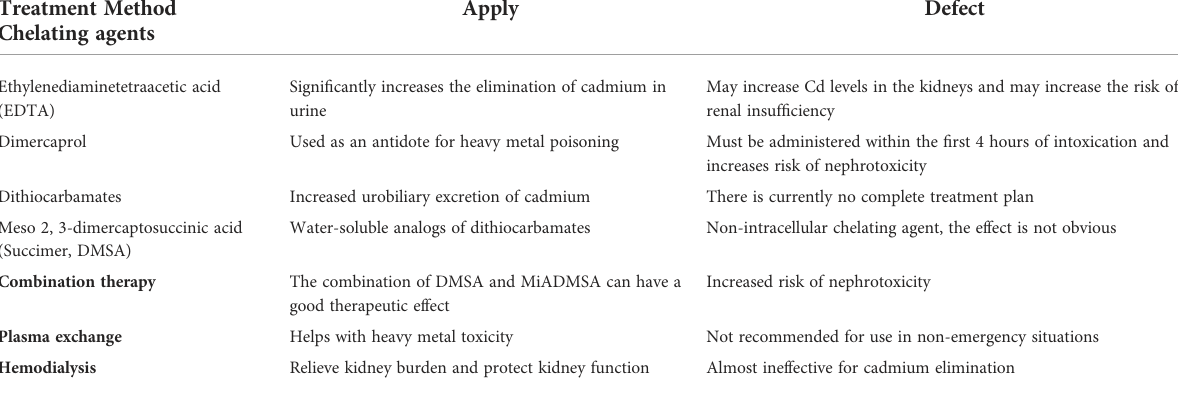
TABLE 1 Common cadmium exposure treatment options. Treatment